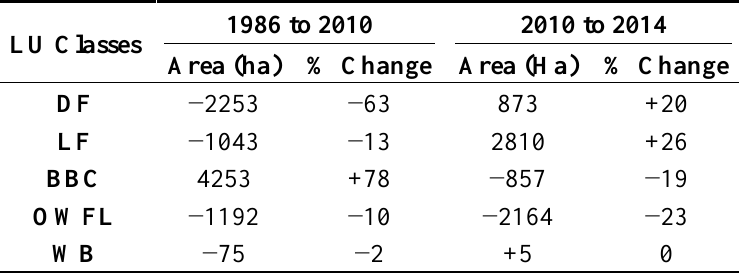
Table 3. Land use and land cover (LULC) change trend from 1986 to